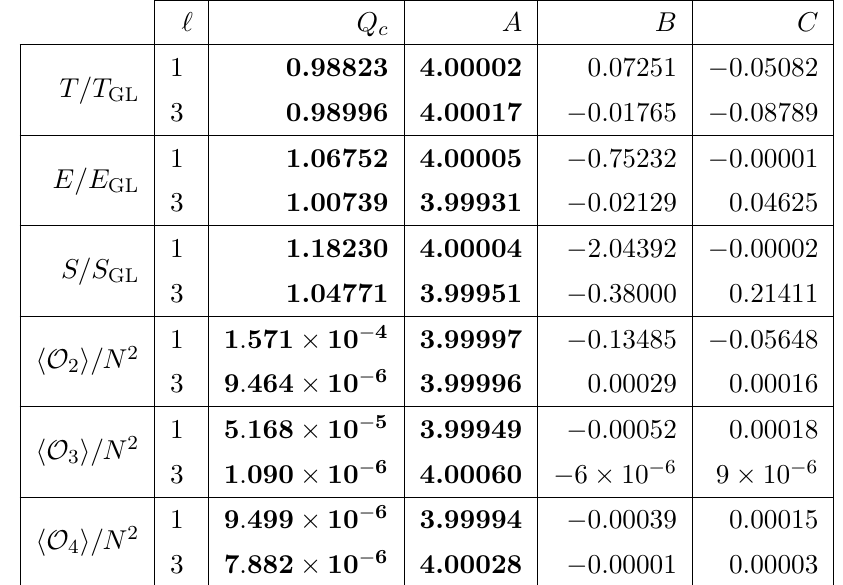
Table 3. Critical exponents and other parameters obtained from the fit of the temperature, energy, entropy and scalar vev’s of the different lumpy solutions in AdS